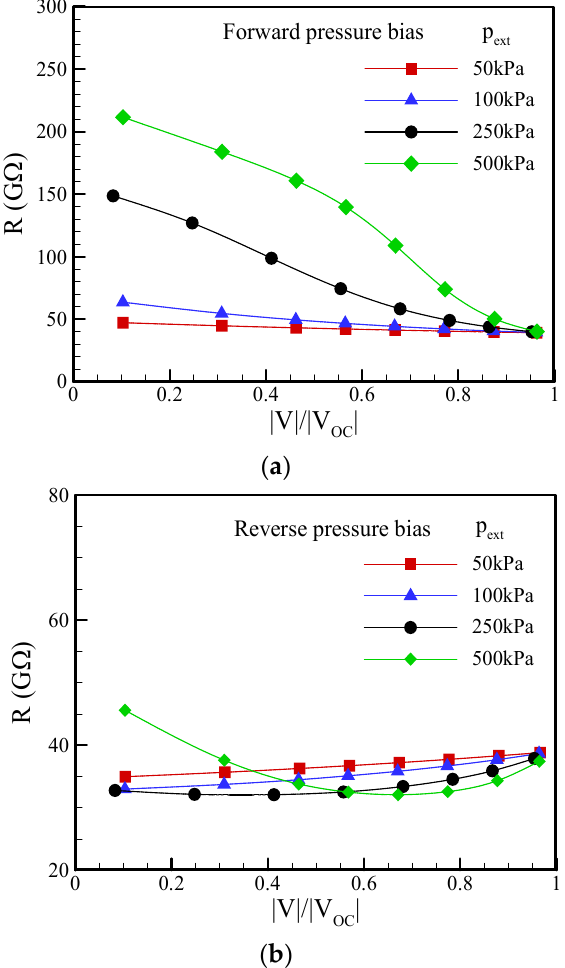
Figure 10. Plots of the variation in electrical resistance (R) with voltage |V| at a salt concentration of c 0 = 0.1 mM under different pressure biases: ( a ) forward pressure bias; ( b ) reverse pressure bias. Note that θ = 1.2°, σ s = −5 mC/m 2 , and b = 20 nm.